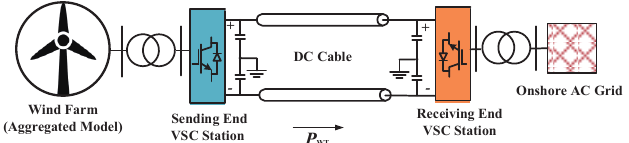
Figure 3. The configuration of the voltage-source converter-based high voltage direct current (VSC-HVDC)